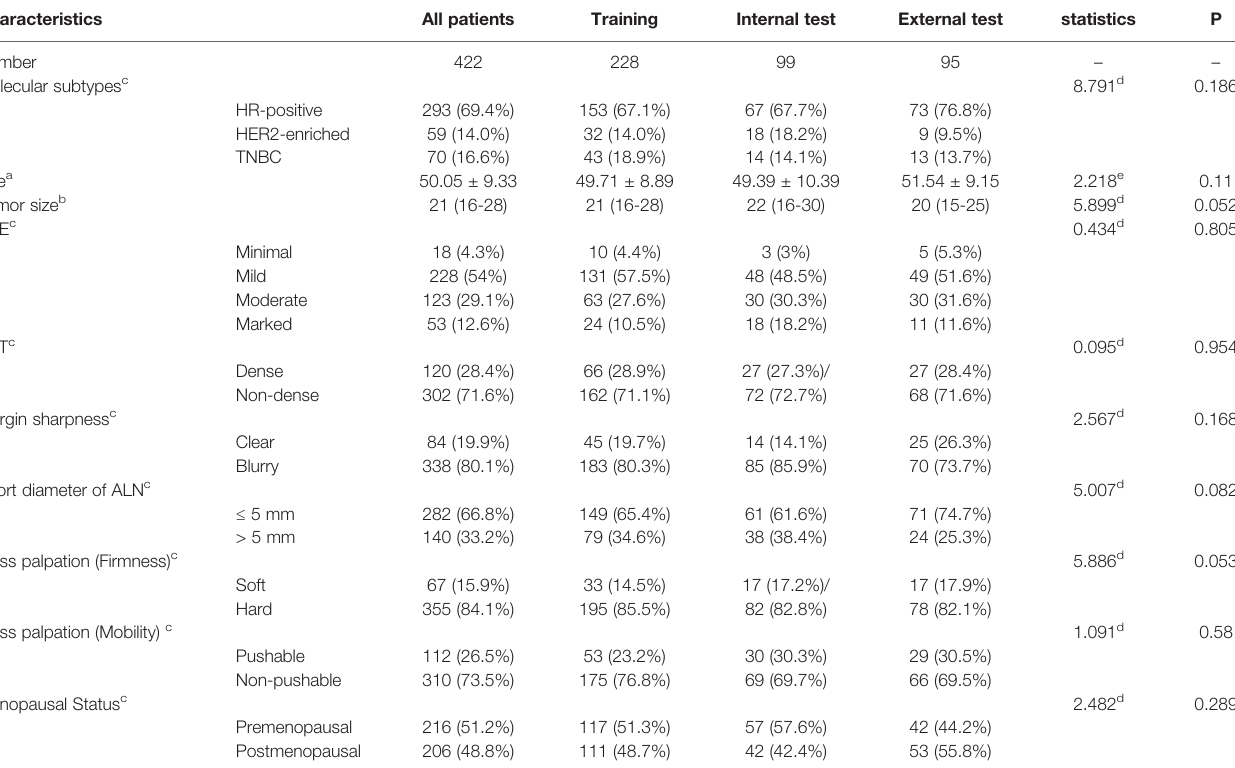
TABLE 1 | Clinical – radiological and pathological characteristics of patients in the training, internal, and external cohorts. Characteristics All patients Training Internal test External test statistics P Number 422 228 – – Molecular subtypes